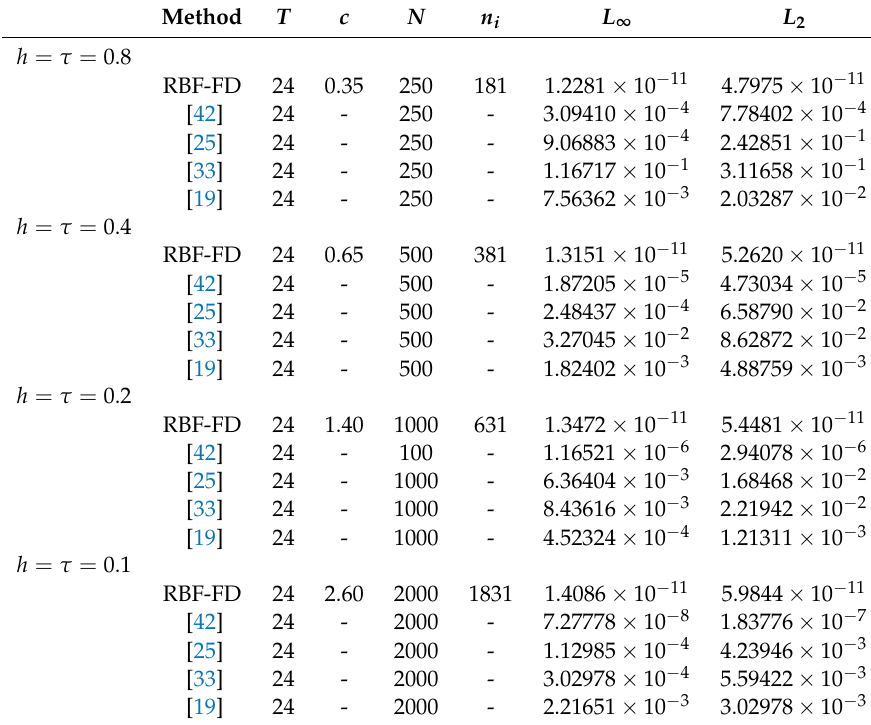
Table 7. The L ∞ and L 2 errors under different mesh steps h = τ with N = 250 and n i = 181 at T = 24 for Example 4.